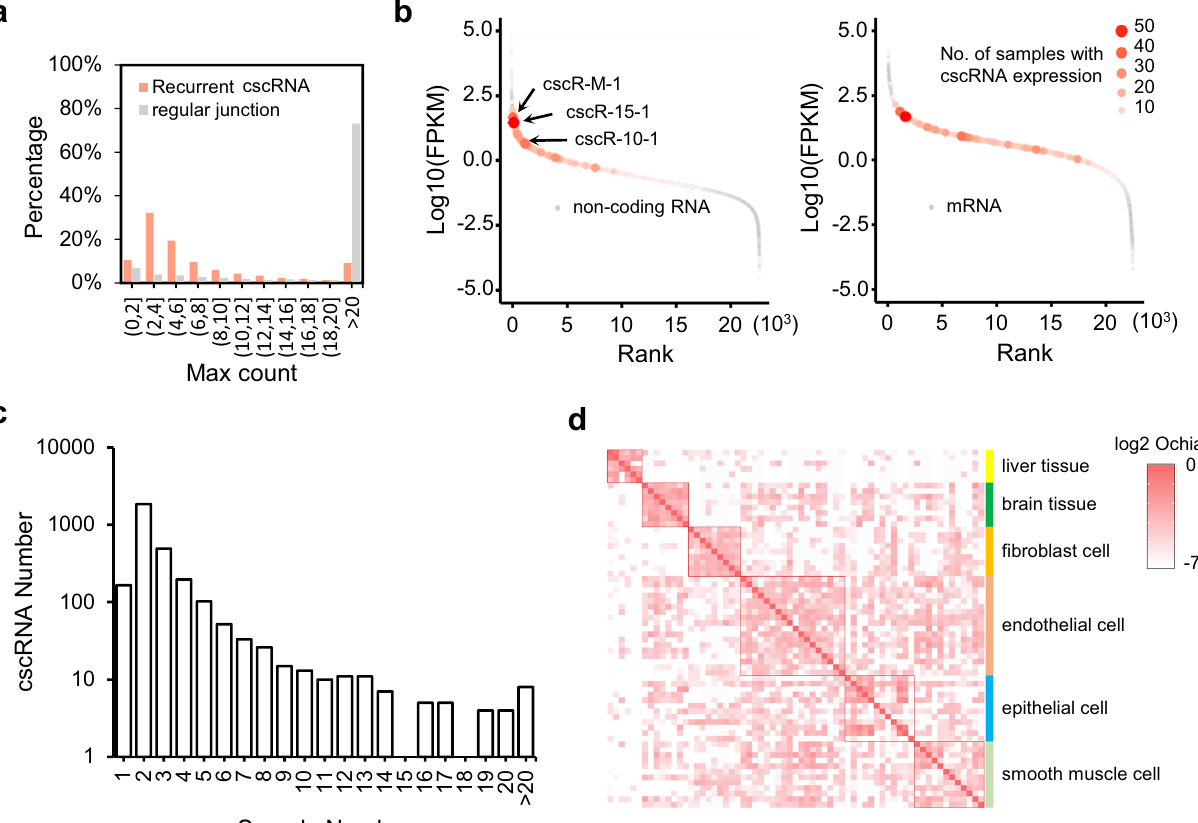
Fig. 2 Expressions of the recurrent cscRNAs. a Distributions of the maximum RNA-seq read counts, among the 271 human samples from ENCODE, on the cross-strand junction sites of the recurrent cscRNAs or 10,000 randomly selected regular exon – exon junction sites. b The maximum of the FPKMs among the 271 human samples of the recurrent cscRNAs on the background of all the annotated long non-coding RNA (left) or mRNA (right) species. The size of each dot indicates the number of samples in which the cscRNA is expressed. The 3 most frequently found cscRNAs among all the samples are marked on the plot. c Distributions of the numbers of different biological samples in which the recurrent cscRNAs are expressed. d Similarity matrix showing the log2 Ochiai values based on the recurrent cscRNAs shared by some of the 271 human samples from ENCODE. Refer to Fig. S7 for the similarity matrix for all of the 271